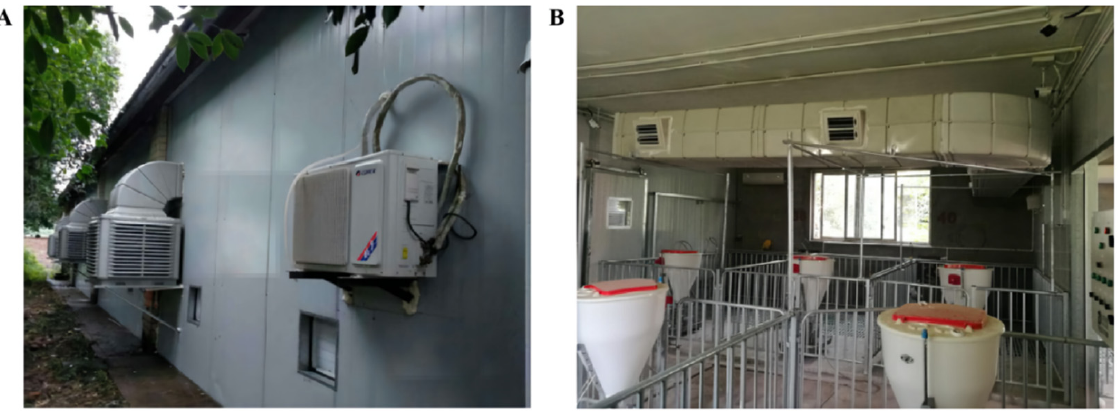
Figure 1. Environmentally controlled experimental pig house with thermal insulation and air conditioning units. ( A ) Ambient wall and external equipment. ( B ) In-house temperature control equipment and breeding environment.